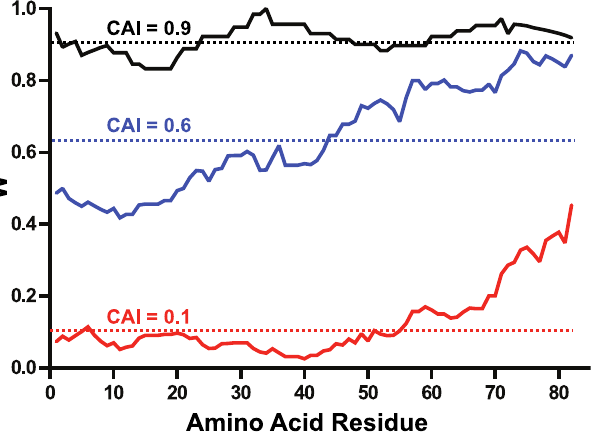
Fig 1. Optimization of the vpu gene for expressionin E . coli . Codon usageis presented by plotting the relativeadaptiveness, w , values (a moving geometric mean with a 10-residue window)as a function of the residue number. Codonusage analysisof the native HIV-1 Vpu gene against the reference set of E . coli and H . sapiens are shown as red and blue traces. The codonusage of the vpu gene optimizedfor expressionin E . coli is shown in black. The codon adaptation index (CAI, relative adaptiveness averagedover the entire length of a sequence)for each gene is shown as a